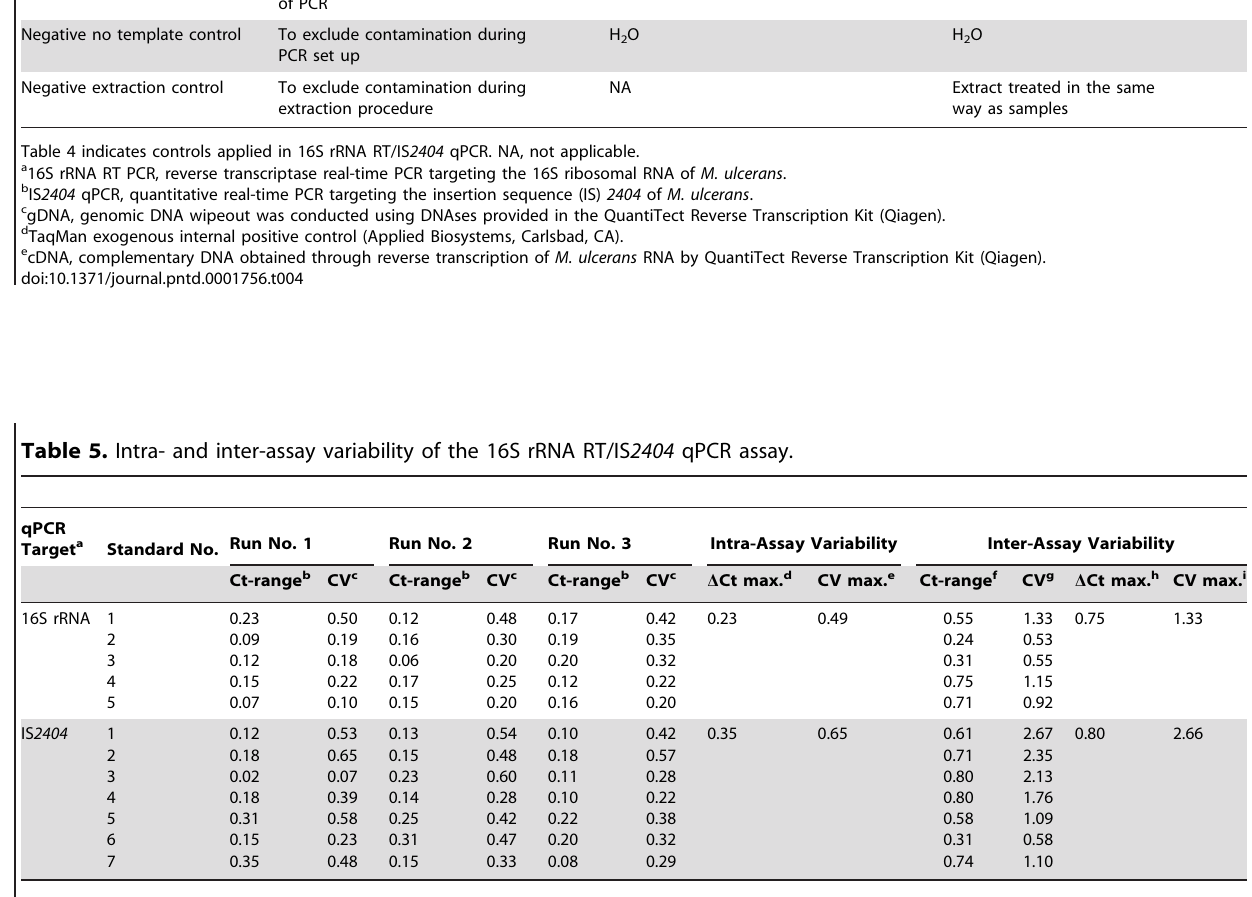
Table 4 indicates controls applied in 16S rRNA RT/IS 2404 qPCR. NA, not applicable. a 16S rRNA RT PCR, reverse transcriptase real-time PCR targeting the 16S ribosomal RNA of M. ulcerans . b IS 2404 qPCR, quantitative real-time PCR targeting the insertion sequence (IS) 2404 of M. ulcerans . c gDNA, genomic DNA wipeout was conducted using DNAses provided in the QuantiTect Reverse Transcription Kit (Qiagen).